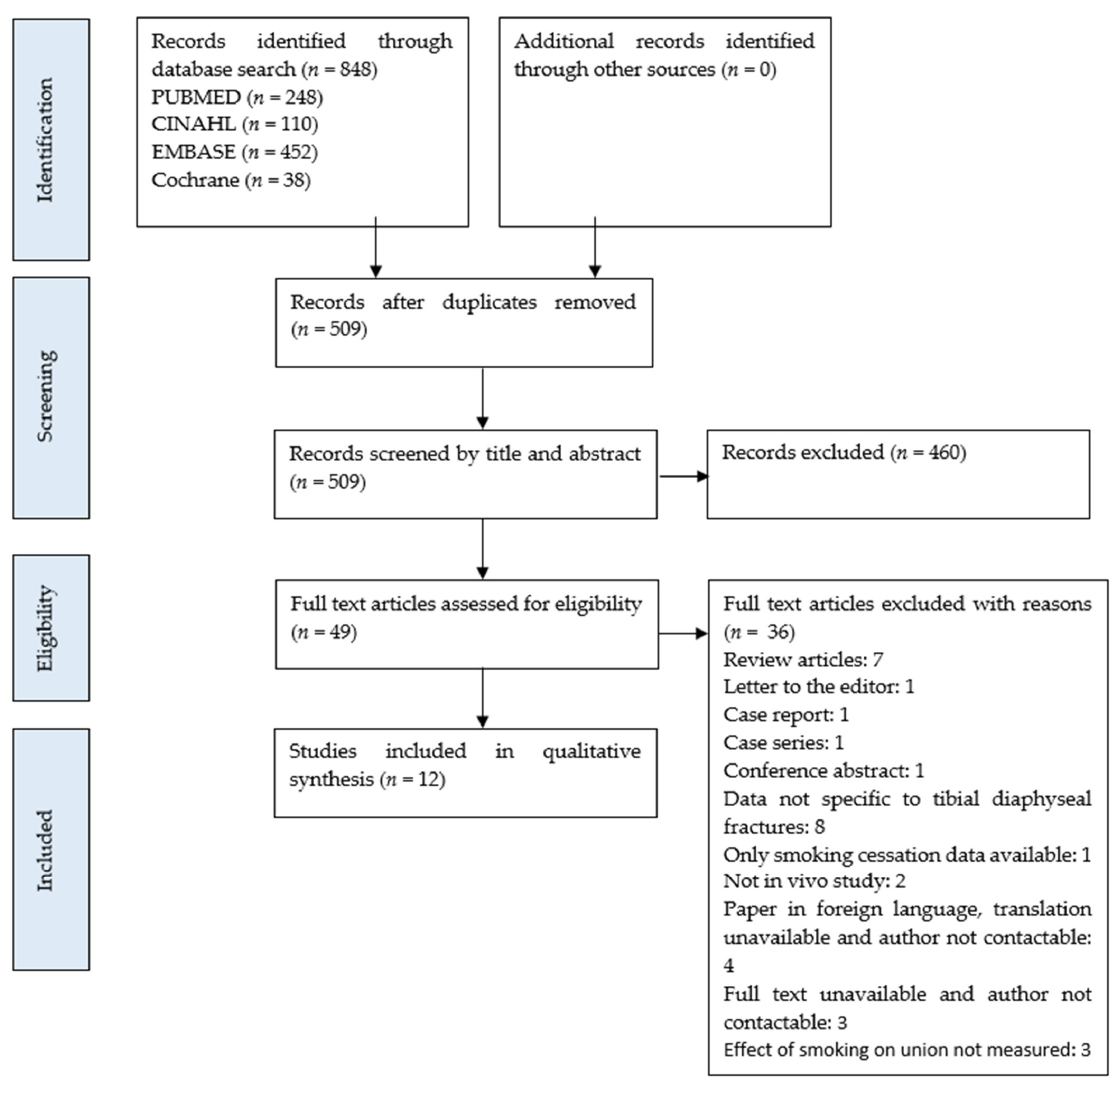
Figure 1. PRISMA Flowchart.